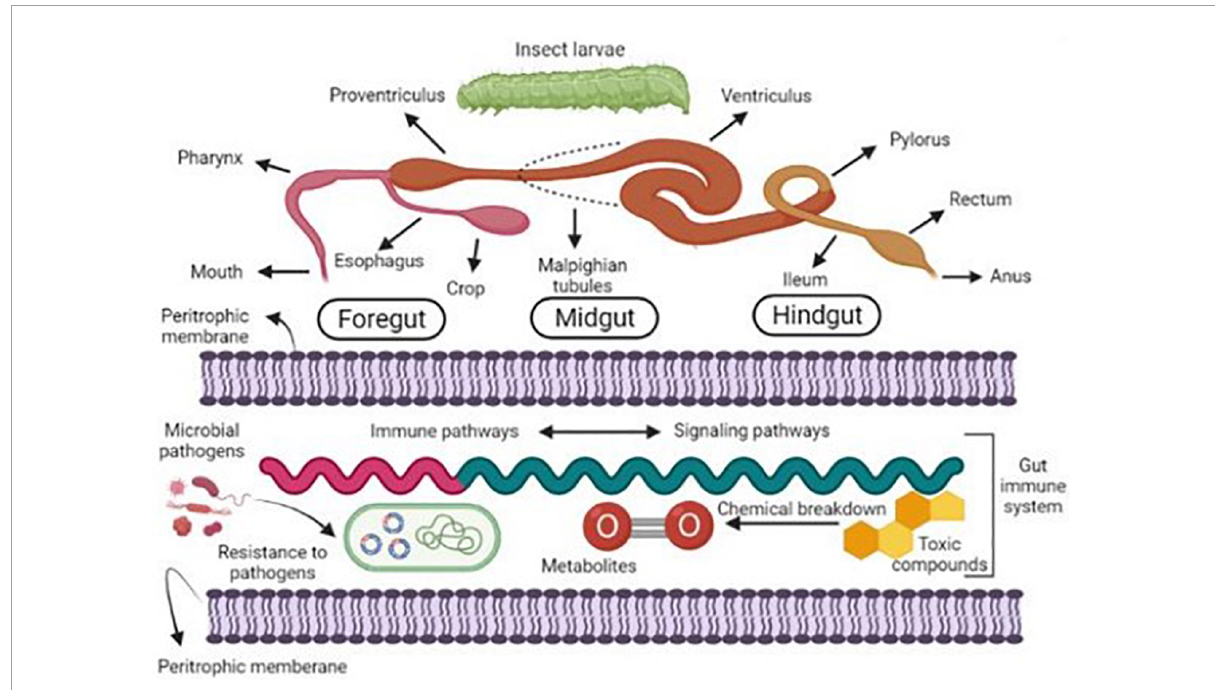
FIGURE3 Graphical representation of gut microbes’ development of resistance against